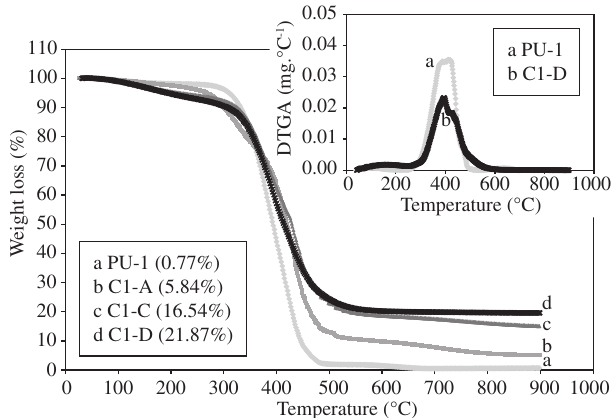
Figure 9. TGA curves of the PU-1 and inorganic modified polyurethanes derived from PU-1 (C1). In brackets: the experimental inorganic content (percent of the samples left after heating up to 900 °C). The inset shows the first derivative of TGA curves for samples PU-1 and C1-D.